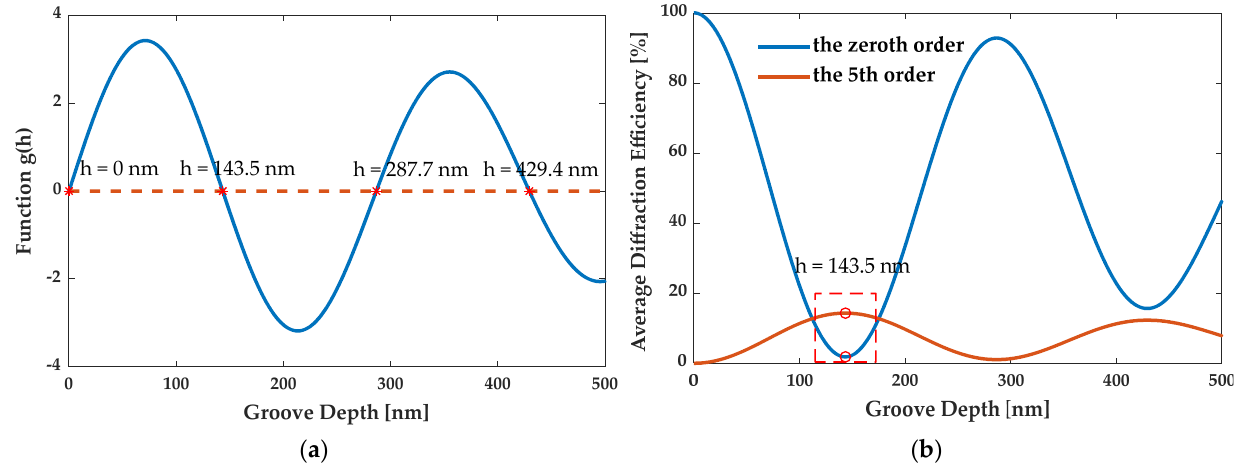
Figure 12. ( a ) The critical points of the groove depth h. ( b ) The average diffraction efficiency of the zeroth and 5th order as a function of the groove depth for the 5th order enhanced grating with three segmented ridges.